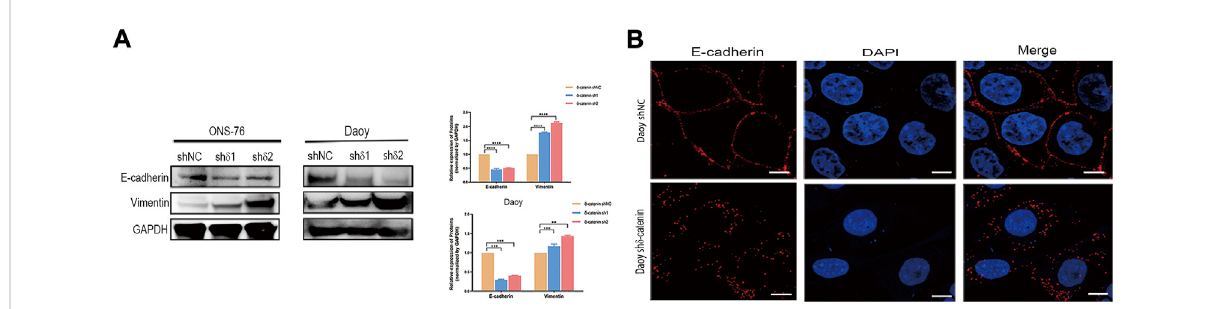
FIGURE 5 Delta-catenin attenuates medulloblastoma cell migration and invasion by targeting EMT pathway. (A) Western blot analysis of EMT pathway markers (E-cadherin and vimentin) following lentiviral transfection of ONS-76 and Daoy cells. GAPDH was used as a control. (B) Representative images (×100 magni fi cation) of E-cadherin in Daoy sh delta-catenin and control cell lines, via immuno fl uorescence staining. Scale bars, 5 μ